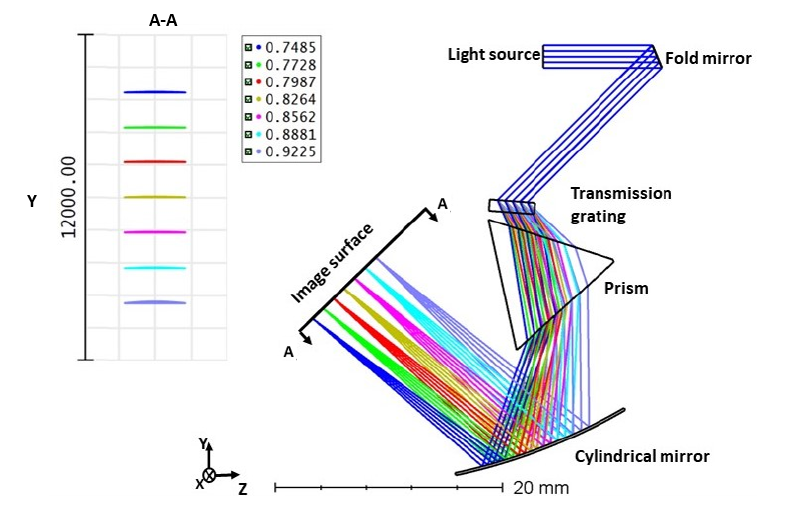
Figure 6. Linear k space spectrometer using grating and prism after